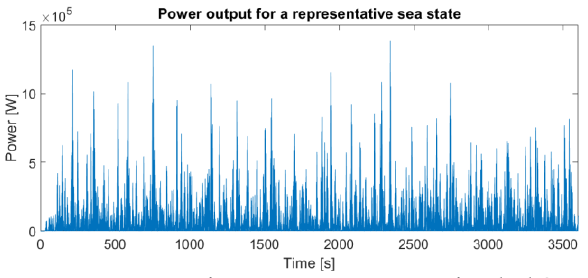
Fig. 12. Metric for average power output of RM3 point